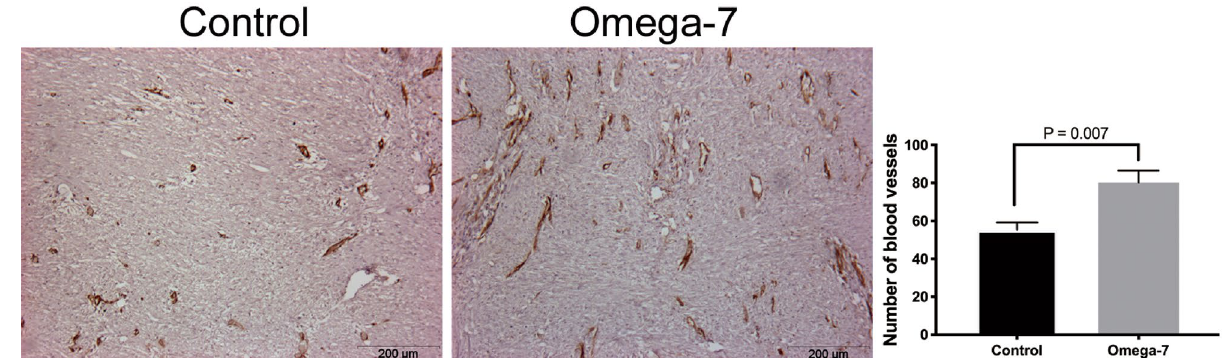
Figure 6. Number of blood vessels in grafted wounds. The number of vessels was counted using MMP-2 staining in grafted wounds at 14 days in eight sheep (8 treated and 8 control sites). Data are expressed as mean ± SEM. Scale bar in micrographs: 200 μm. Photographs taken and compiled, by authors, in Adobe Photoshop CC 2020 (https ://www.adobe .com/jp/produ cts/photo shop.html) without changing the content of images